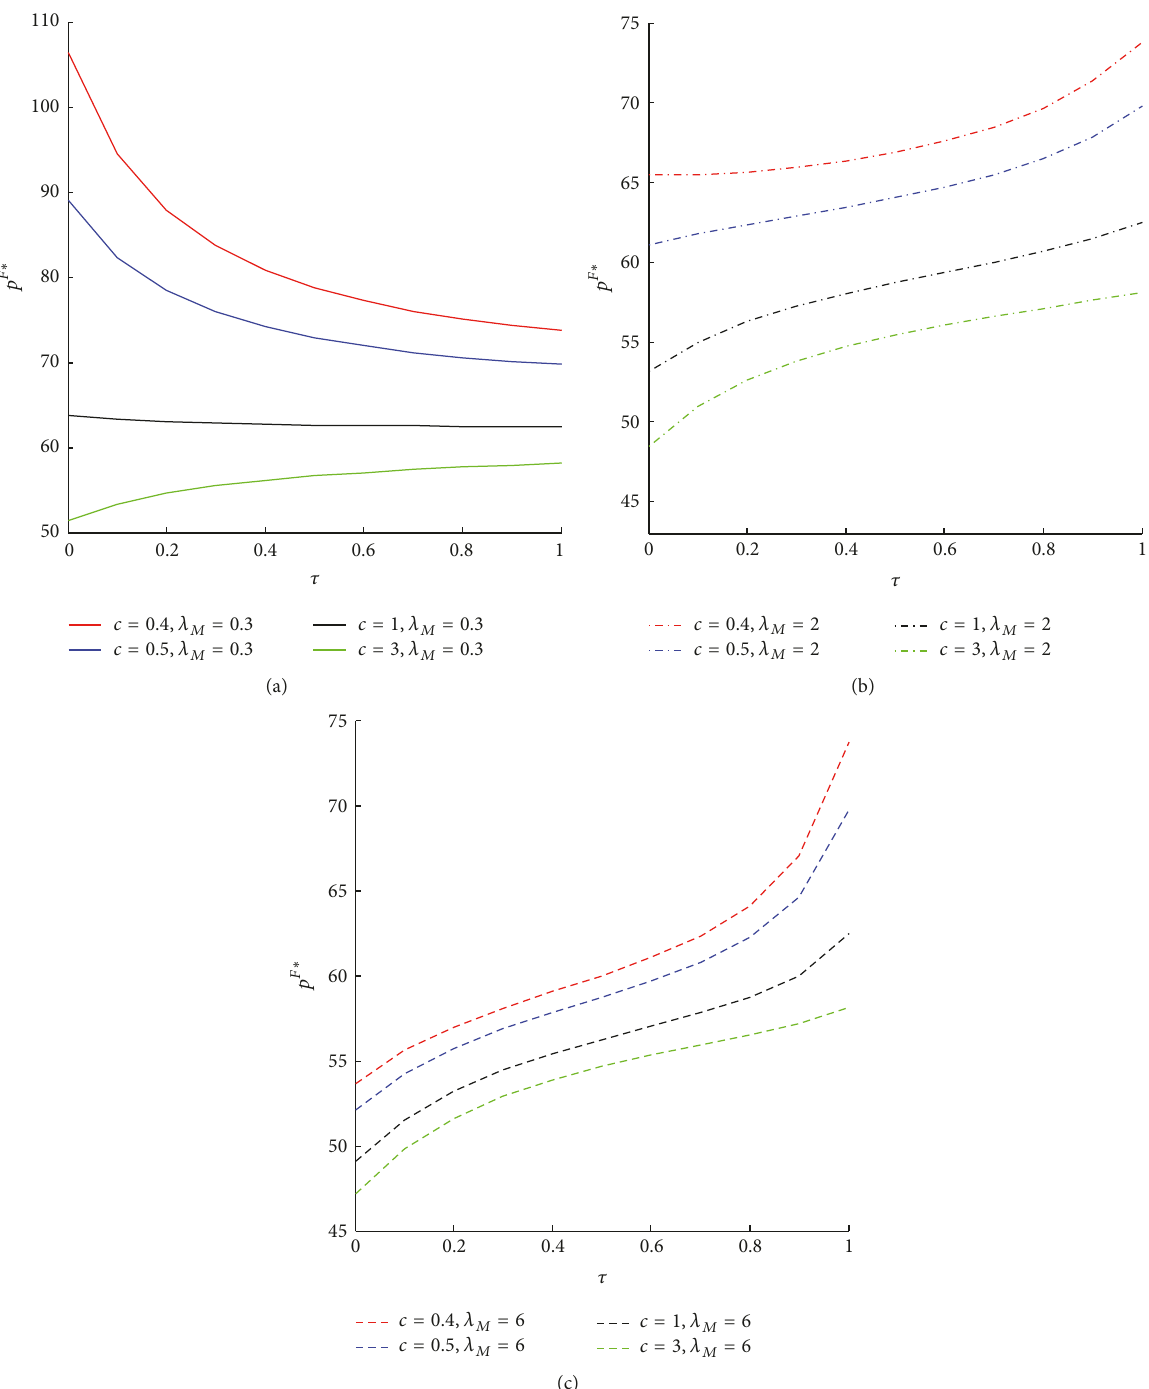
Figure 5: Effects of 𝜏 on the equilibrium selling price ( 𝑎 = 600 , 𝛼 = 8 , 𝛽 = 10 , V 𝑆 = 3 , V 𝑀 = 2 , 𝜆 𝑆 = 5 , 𝜀 = 0.4